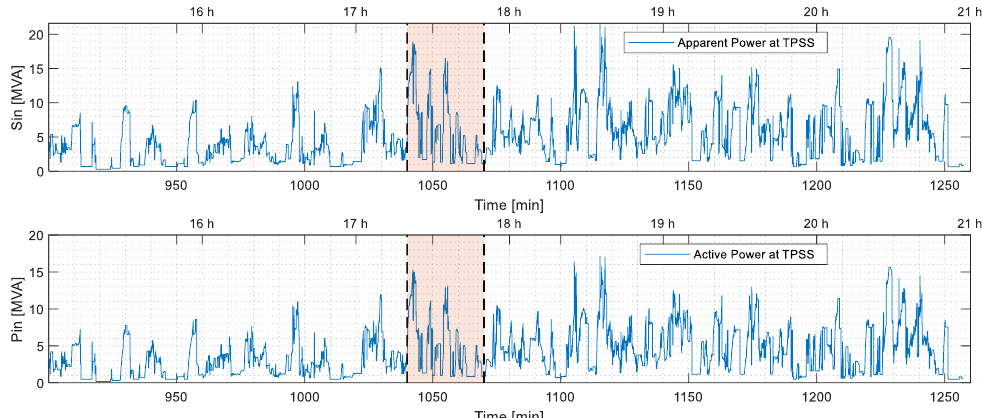
Figure 19. Apparent and active power consumption at substation #2 in normal mode. For a connection to a three-phase 220 kV voltage level the short circuit power at substation #2 is S SC3 φ = 1000 MVA. Accordingly, the corresponding V UF is given (in percentage) in Figure 20.